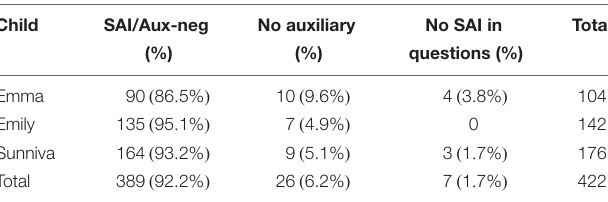
TABLE 2 | Target-like use of finite auxiliaries/copula in questions and negative declaratives versus non-target-like structures with missing auxiliaries or lack of SAI in Emma, Emily and Sunniva’s